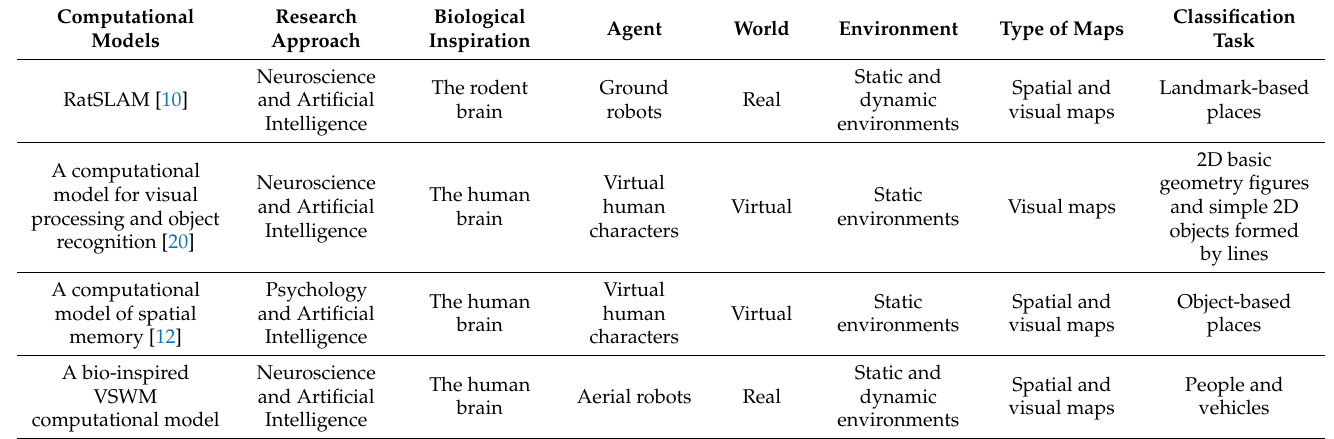
Table 1. Relevant characteristics of the proposed model and related